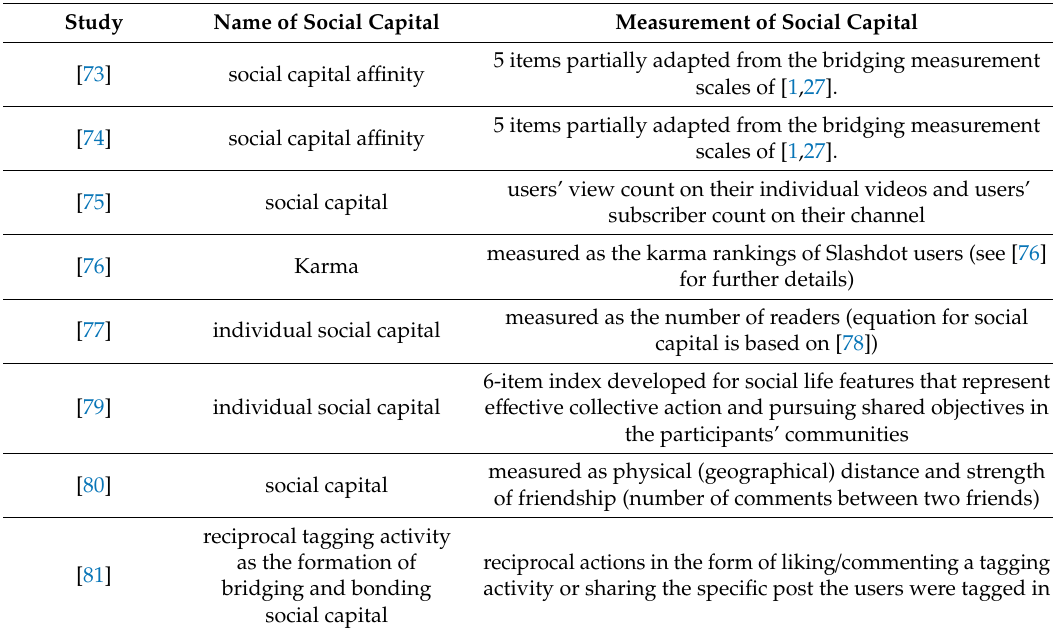
Table 4. List and basis of comparison in the cases of 12 publications employing unique measurement approaches.